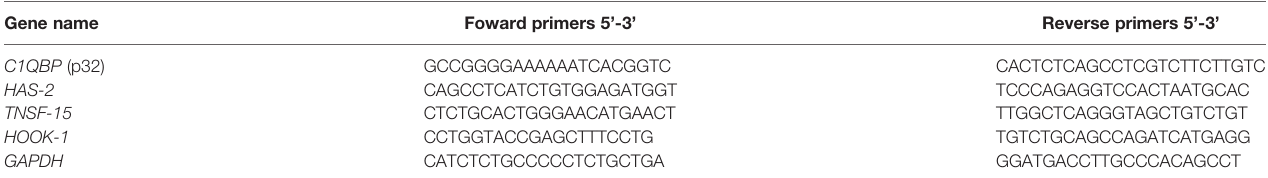
TABLE 1 | List of the primers used in